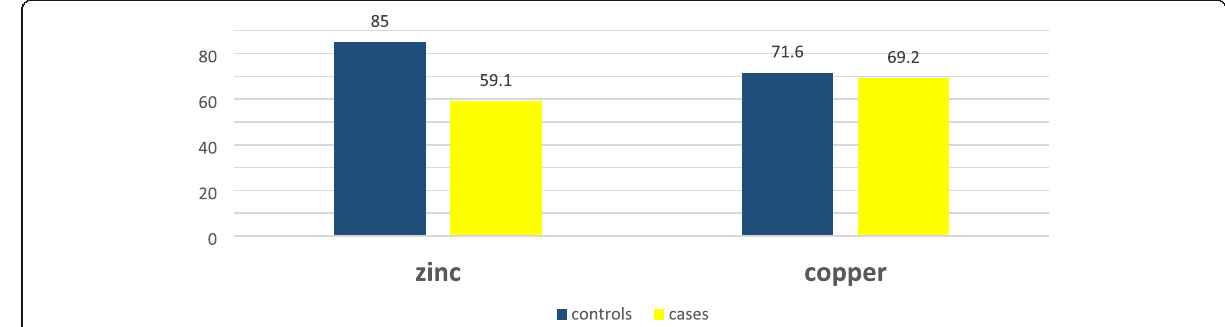
Fig. 1 Comparison between cases and controls as regards the mean level of zinc and copper in